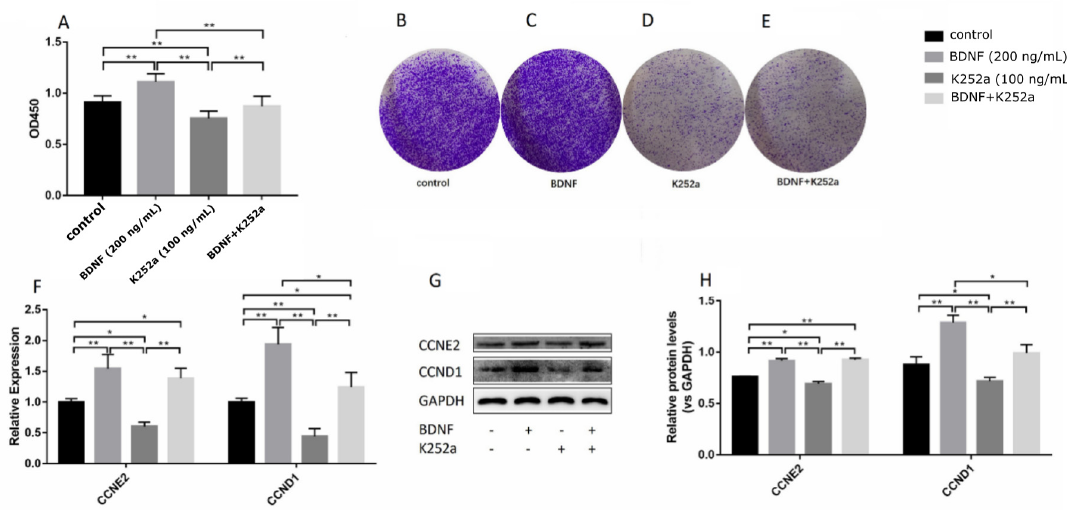
Figure 5. E ff ects of BDNF alone or that combined with K252a on the proliferation in Ishikawa cells. Ishikawa cells were monocultured with 100 ng / mL K252a for 30 min and then cocultured with 200 ng / mL BDNF for 24 h. ( A ) Cell counting kit-8 analysis was performed for the detection of cell viability. ( B ) Colony formation assay was used in detecting control cell proliferation. ( C ) Colony formation assay was used in detecting the cell proliferation treated with BDNF. ( D ) Colony formation assay was used in detecting the cell proliferation treated with K252a. ( E ) Colony formation assay was used in detecting the cell proliferation treated with K252a and BDNF. ( F ) Relative mRNA expression levels of CCND1 and CCNE2 genes were detected by qRT-PCR. ( G ) Protein levels of CCND1 and CCNE2 genes were detected by Western blot analysis. ( H ) Relative protein levels of CCND1 and CCNE2 genes were analyzed by grey scanning. The expression levels of mRNA and proteins